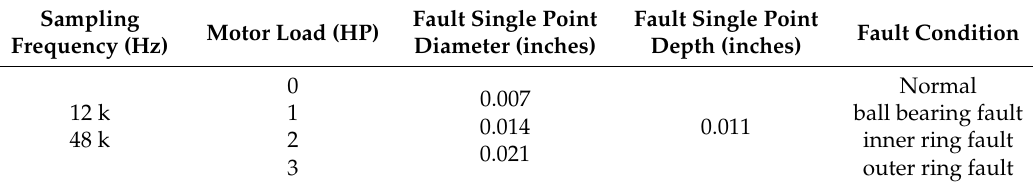
Figure 3. Ball bearing experiment platform. Table 1. Types of ball bearing faults.